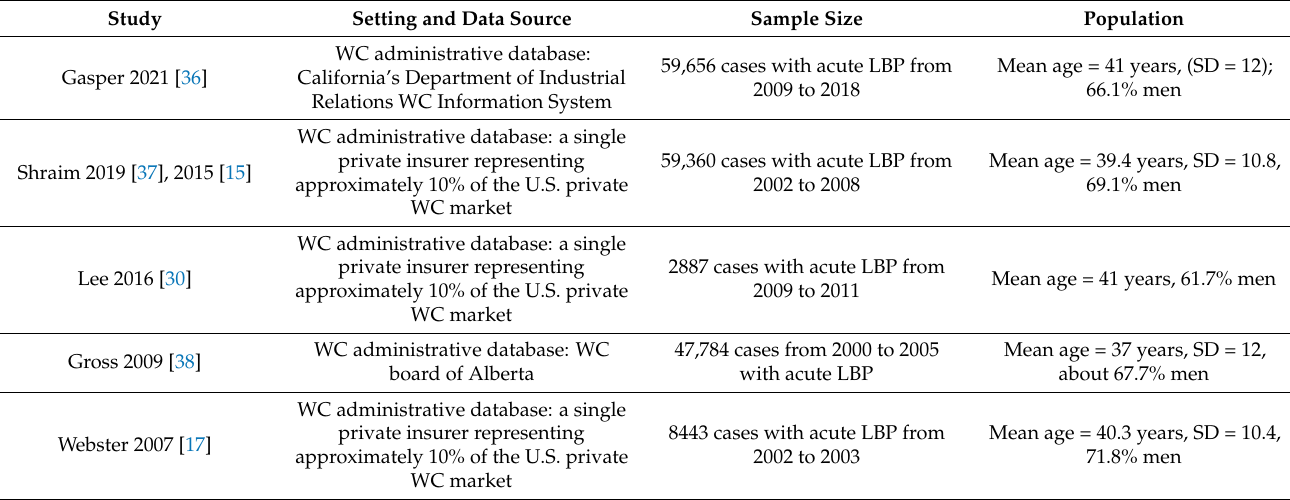
Table 1. Characteristics of included